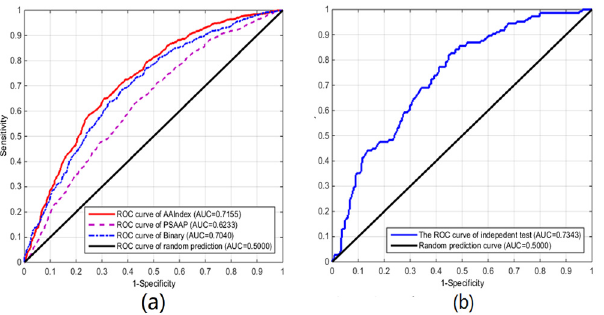
Fig 2. (a)The 10-fold ROC curves of the three feature constructions on the balanced training dataset. (b) The 10-fold ROC curve of AAIndex feature construction on the independent test.